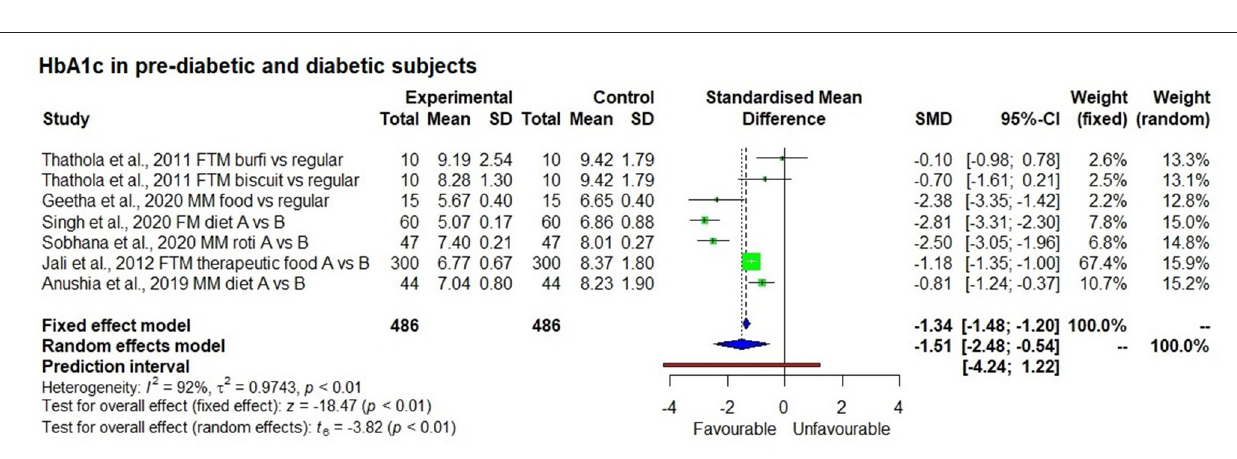
FIGURE 7 | Effect of long term consumption of millet on HbA1c levels in pre-diabetic and diabetic subjects compared to the control group consuming a regular diet or pre vs post intervention